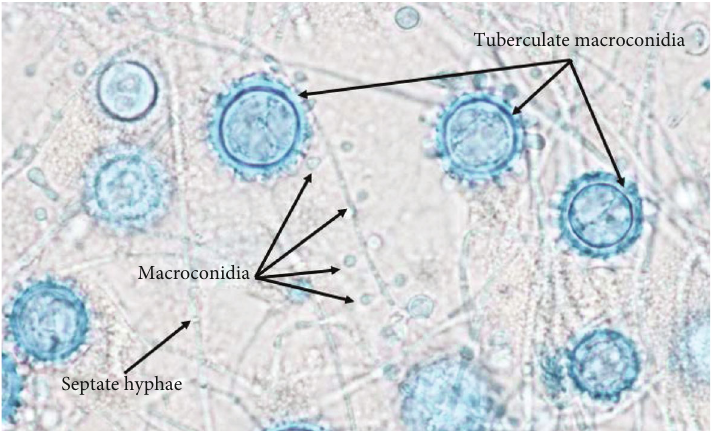
Figure 5: Lactophenol cotton blue tape prep from the right knee joint aspirate culture, 1000x, with labeling of the morphologic structures used for organism identi fi cation.